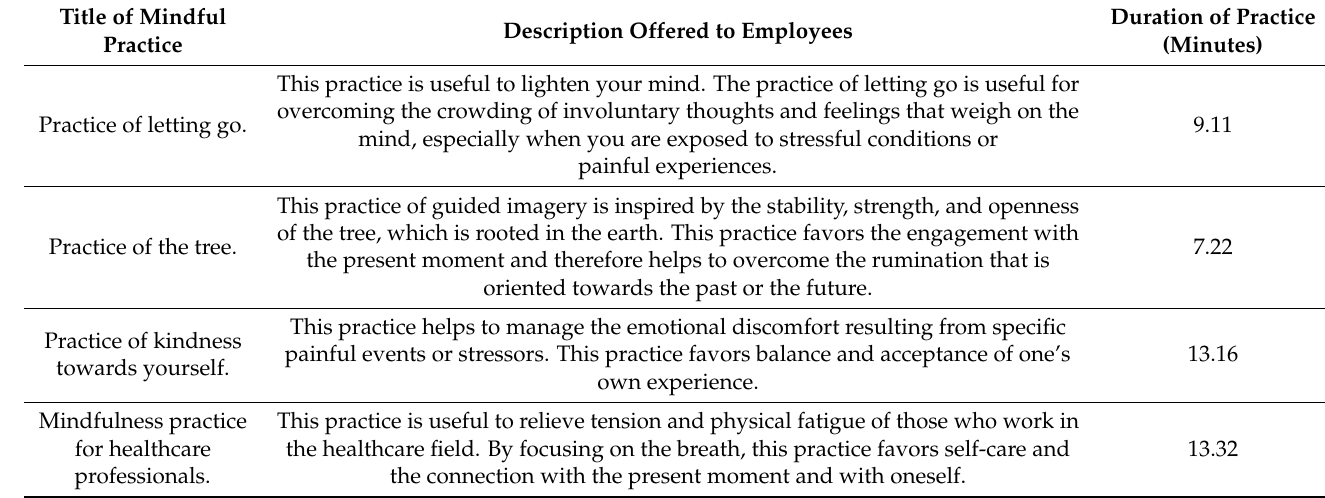
Table 1. Mindful practices for hospital